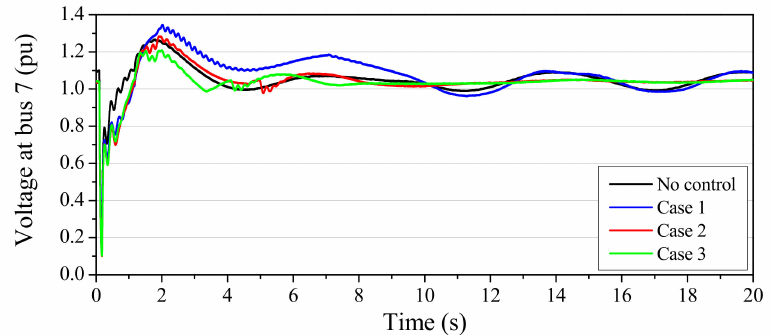
Figure 19. Voltage at bus 7 (with PV system installed).